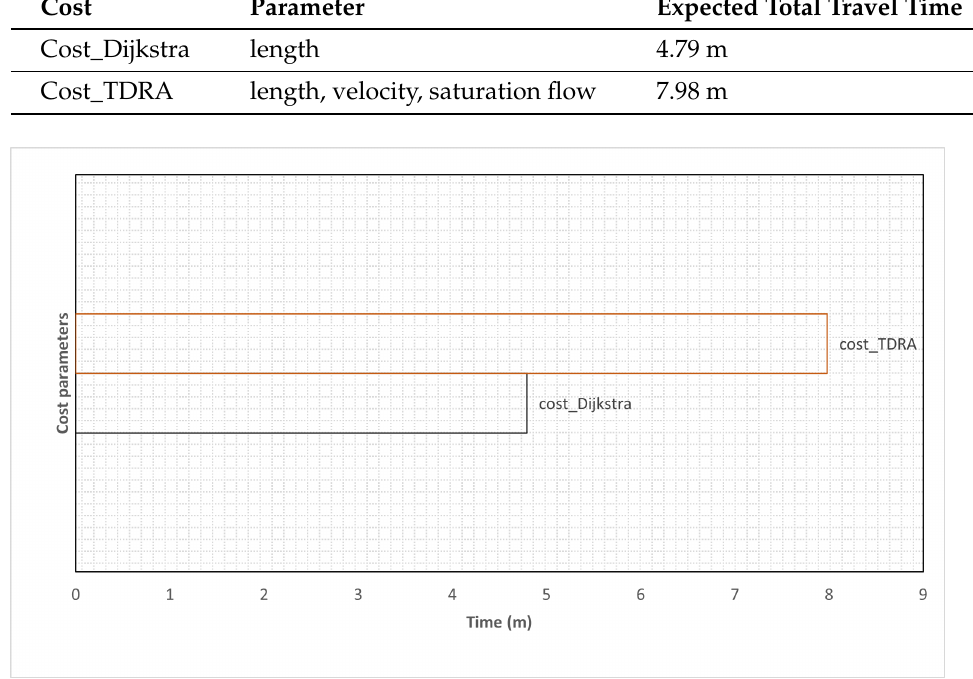
Figure 12. Impact of the cost parameters on the total travel time with Dijkstra’s